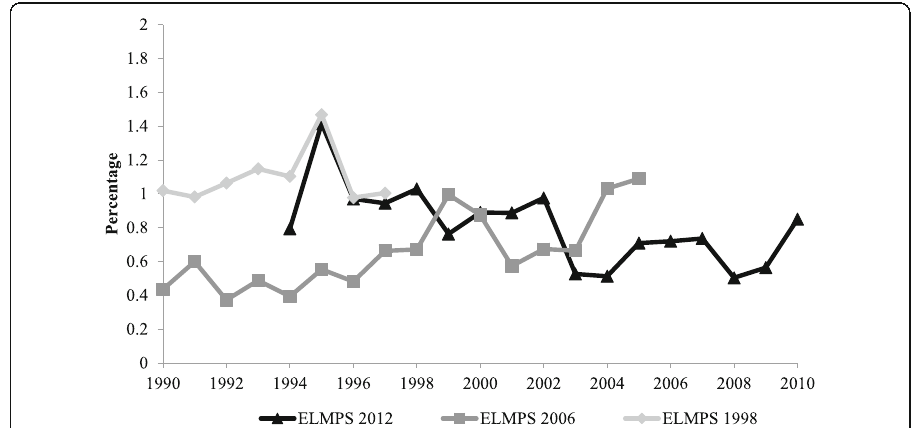
Fig. 9 Employment to inactivity separation rate (percentage) by wave, males aged 15 – 54, 1990 – 2010.